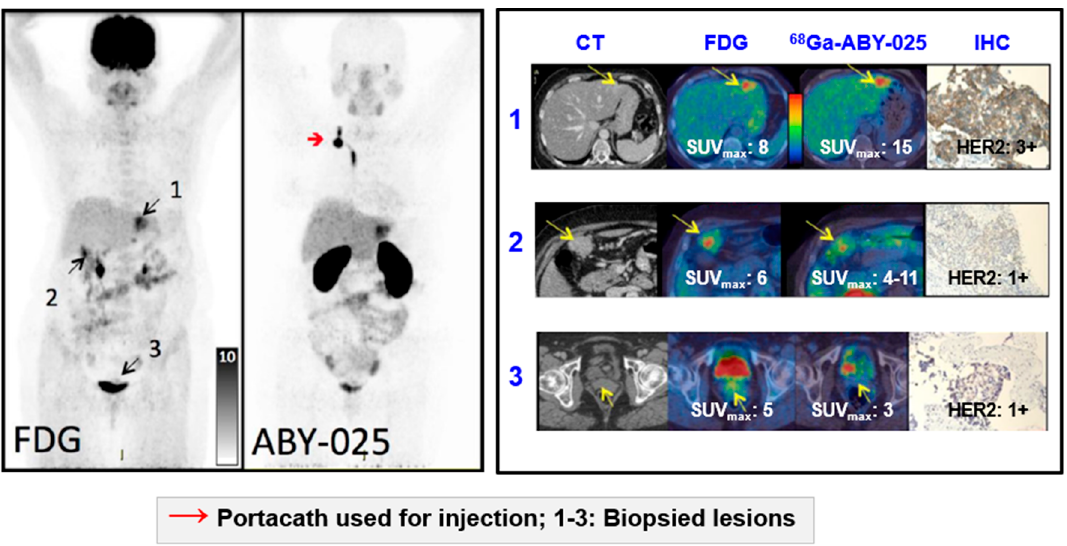
Figure 11. Based on the results from [ 68 Ga]Ga-ABY-025 PET/CT, mixed expression of HER2 in metastatic breast cancer was seen in several patients and confirmed by biopsies in two. Patient 9 had HER2-negative primary tumor and was enrolled as negative control. [ 18 F]FDG-PET/CT showed metastases in left liver lobe, peritoneal lymph nodes, and cervix of uterus. [ 68 Ga]Ga-ABY-025 uptake was high in the liver metastasis, low in peritoneal metastases and absent in the cervical region (not shown). According to IHC, the liver finding was true positive and both other sites were true negative. Adopted from [5].